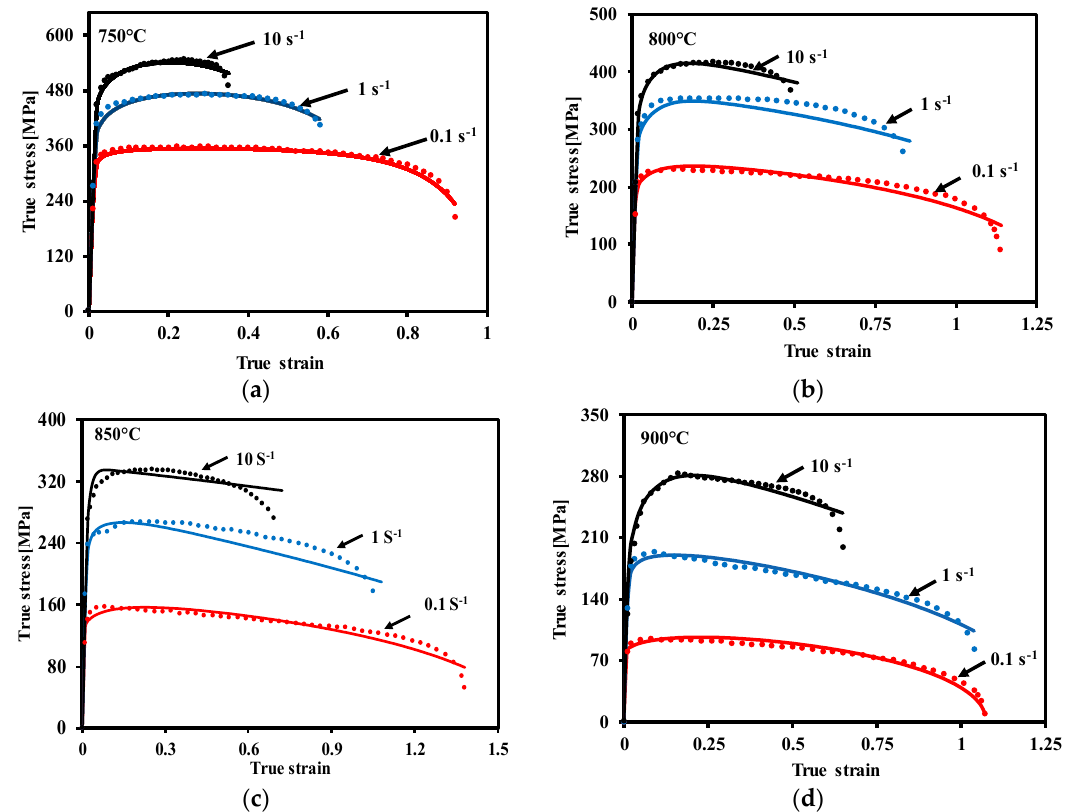
Figure 10. Comparison of stress-strain relationships of TA15 between experimental (symbols) and computed (solid curves) strain-stress at different hot stamping conditions, ( a ) 750 ◦ C, ( b ) 800 ◦ C, ( c ) 850 ◦ C and ( d ) 900 ◦ C. The strain rates used were 0.1 s − 1 , 1 s − 1 and 10 s − 1 .